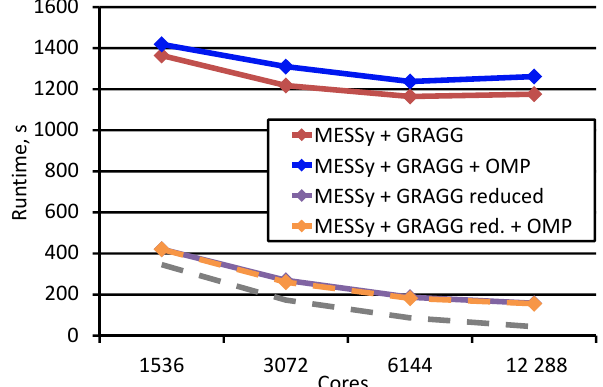
Figure 6. Comparison of the runtime (s) of GRAGG and versions of GRAGG with reduced call frequency, OpenMP, and a combination of both. Output was activated in all test